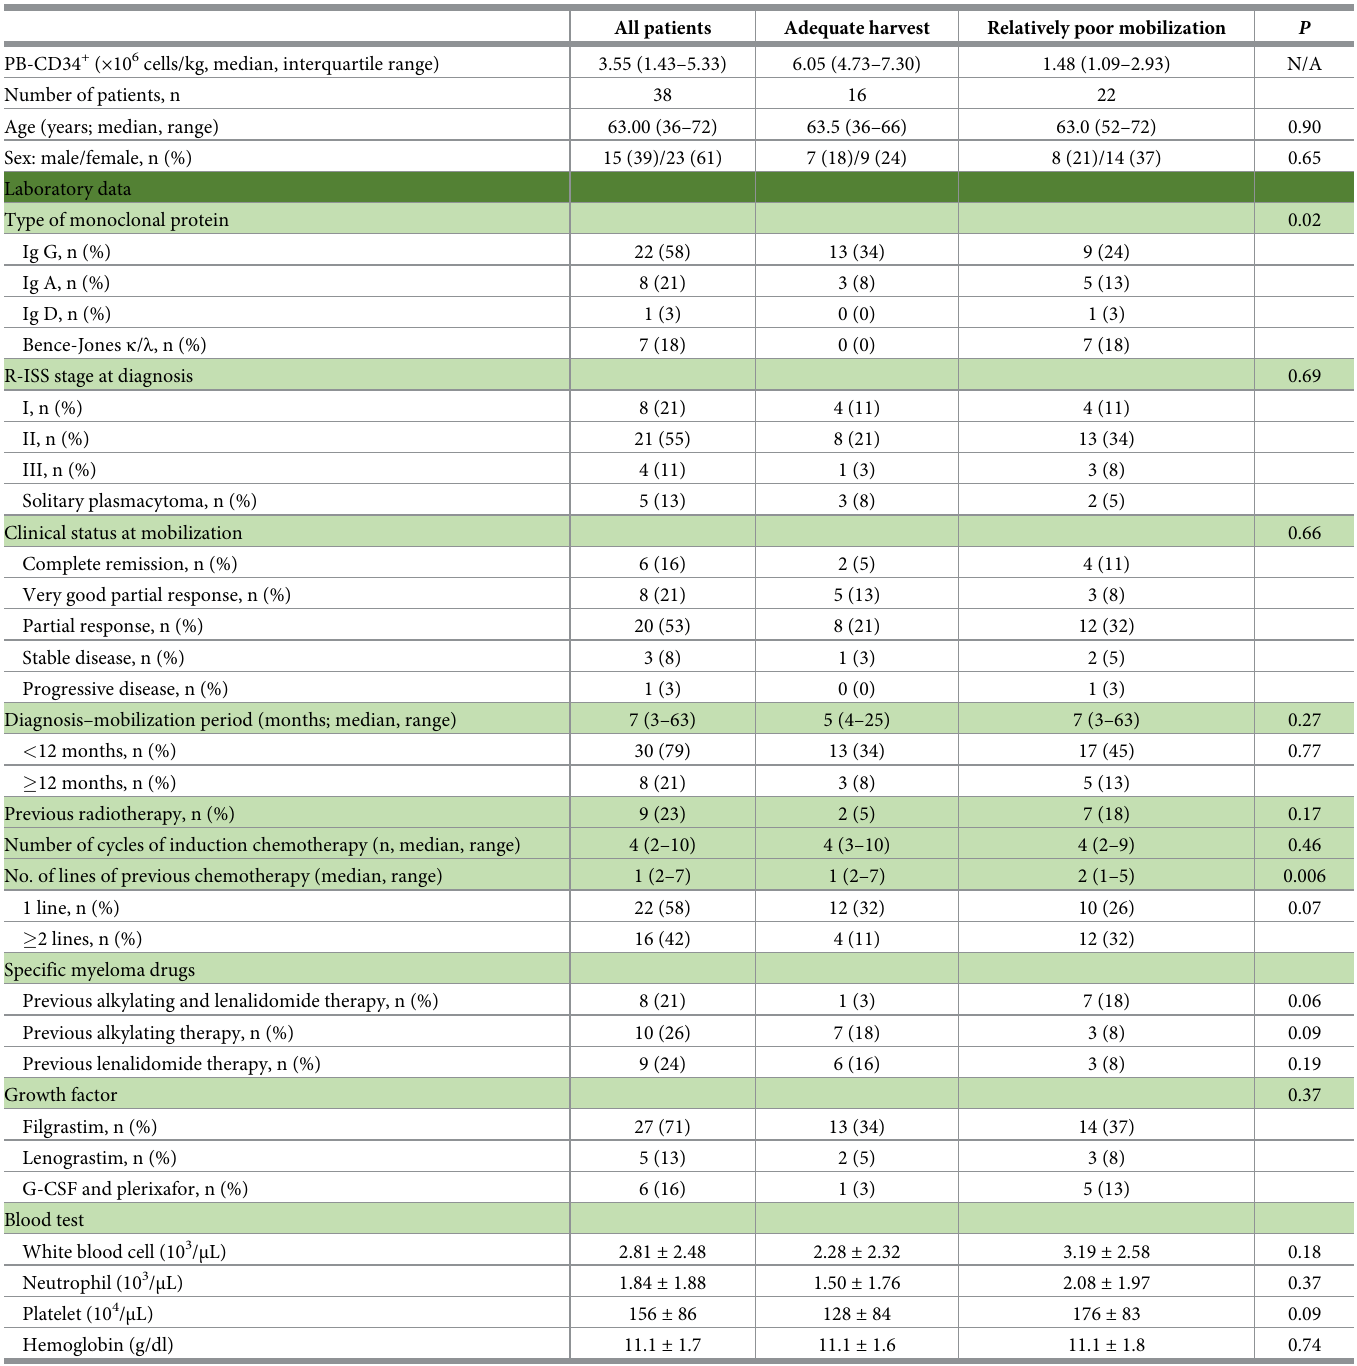
Table 1. Patient characteristics and biochemistry results.